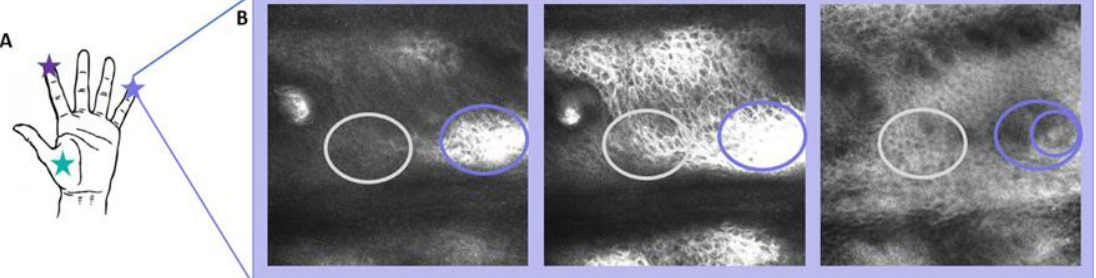
Figure 3. Meissner corpuscles create protrusions of the epidermis into the stratum corneum of glabrous skin. ( A ) Three anatomic positions were analyzed in this study (stars). ( B ) LSM images of a small finger recorded at a depth of 150, 159, and 210 µm. Regions containing an MC are marked by purple ellipses, equivalent regions with MC by gray ellipses.